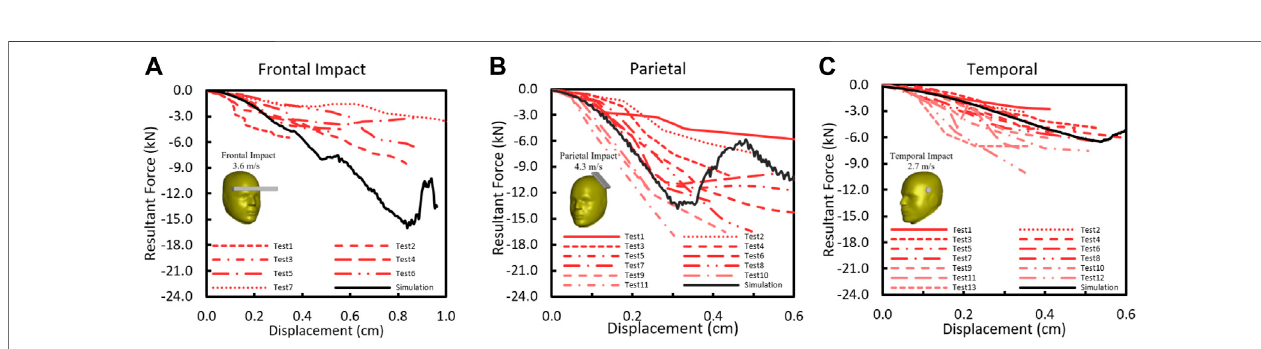
FIGURE7|(A) Force – de fl ectionresponseinskullfrontalbone(Allsopetal.,1988); (B) force – de fl ectionresponseinskulltemporoparietalbone(Allsopetal.,1991); (C) Force – de fl ection response in skull temporal bone (Allsop et al., 1991).